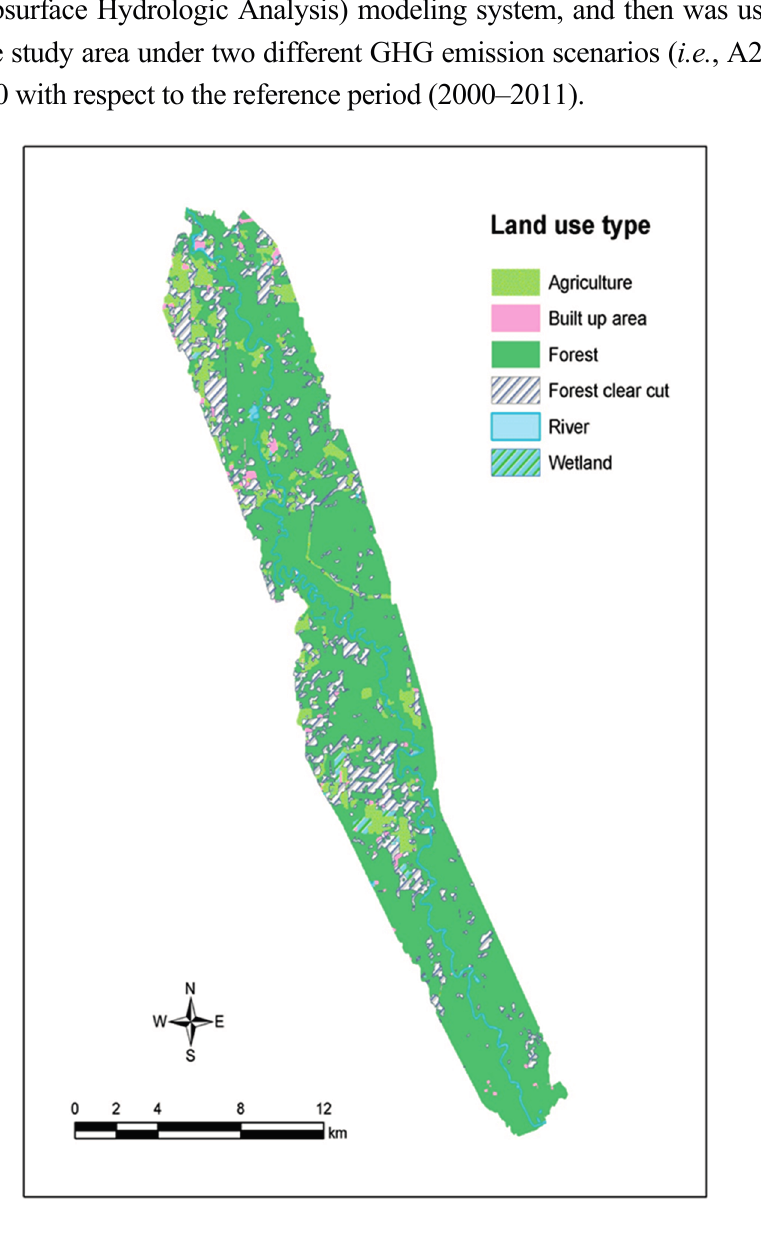
Figure 2. Land use and land cover map of the study area in